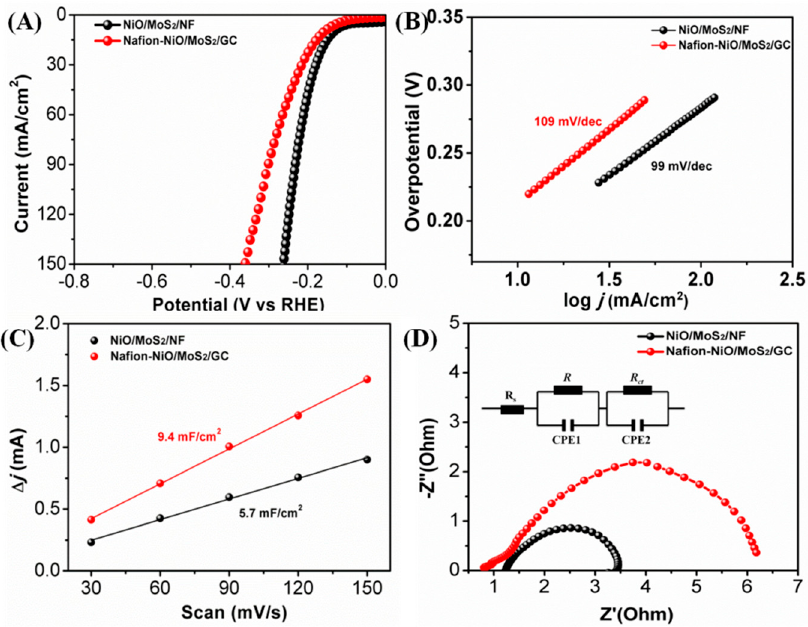
Figure 5. Electrochemical performance for HER. ( A ) J–V curves of representative assembling conditions: NiO/MoS 2 /NF and Nafion-NiO/MoS 2 /GC; ( B ) Tafel plots for Nafion–NiO/MoS 2 /GC and NiO/MoS 2 /NF; ( C ) capacitive current at 0.165 V as a function of the scan rate; ( D ) EIS curves of electrodes at an overpotential of 200 mV.